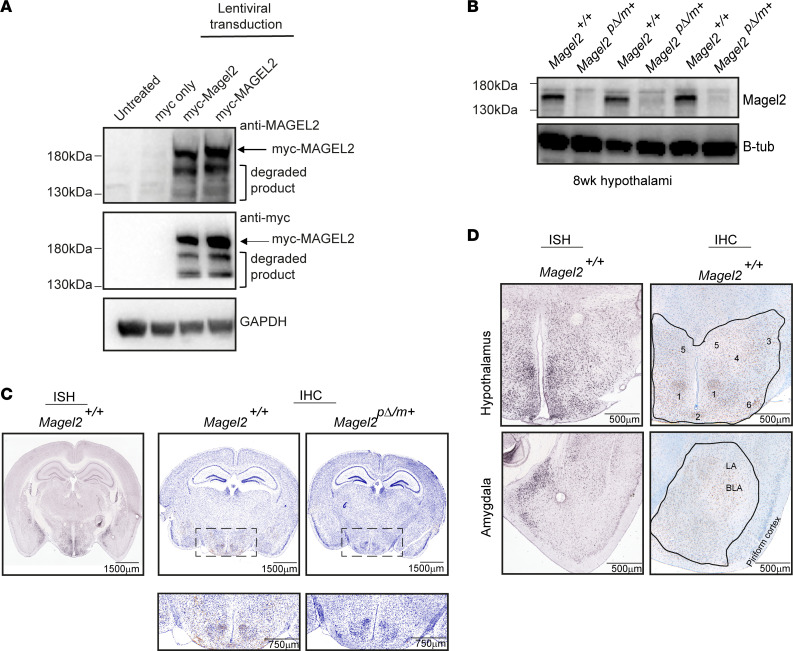
MAGEL2 is expressed in specific brain regions.(A) Western blot analysis detected expression of myc-tagged human and mouse MAGEL2 in HEK293 cells (ATCC, CRL-1573) by lentiviral transduction. Arrow marks myc-tagged exogenous protein; degraded protein products were also detected. GAPDH served as loading control. (B) Western blot analysis confirmed loss of Magel2 in 8-week-old Magel2pΔ/m+ mouse hypothalamuses compared with Magel2+/+. β-Tubulin served as loading control. (C) IHC of an 8-week-old Magel2+/+ mouse brain compared with in situ hybridization (ISH) of Magel2+/+ mouse brain by the Allen Brain Atlas. Note absence of brown staining in null animals. (D) IHC of an 8-week-old Magel2+/+ mouse at the hypothalamus and amygdala as outlined in black. Brown staining indicates Magel2. Anatomical landmarks within the hypothalamus are listed as 1) ventromedial hypothalamic nucleus (VMH), 2) arcuate hypothalamic nucleus (ARH), 3) lateral hypothalamic nucleus (LHA), 4) anterior hypothalamic nucleus (AHN), 5) paraventricular hypothalamic nucleus (PVN), and 6) tuberal nucleus (TU). LA, lateral region; BLA, basolateral region.